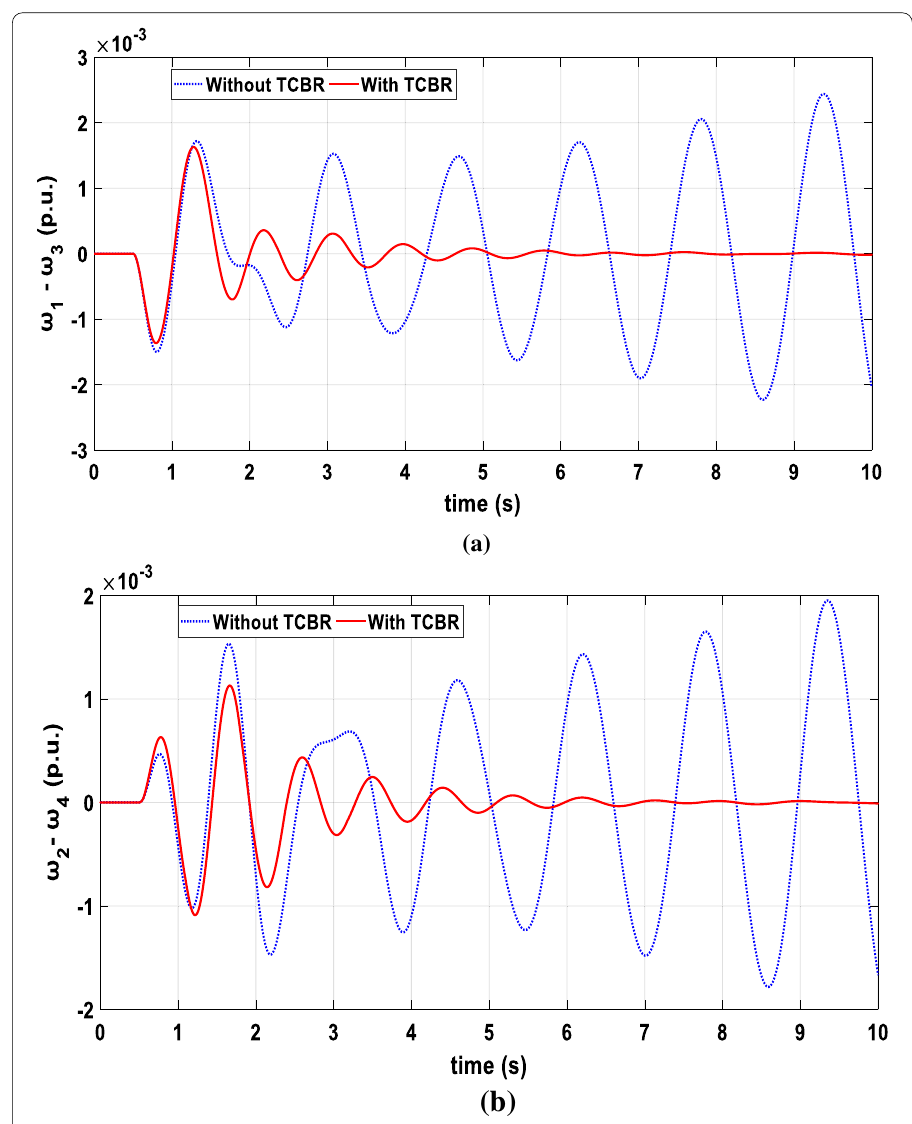
Fig. 6 Case (1) relative generator speeds time‑domain responses, a outer generators relative speed (ω 1 − ω 3 ) in (p.u.), b inner generators relative speed (ω 2 − ω 4 ) in